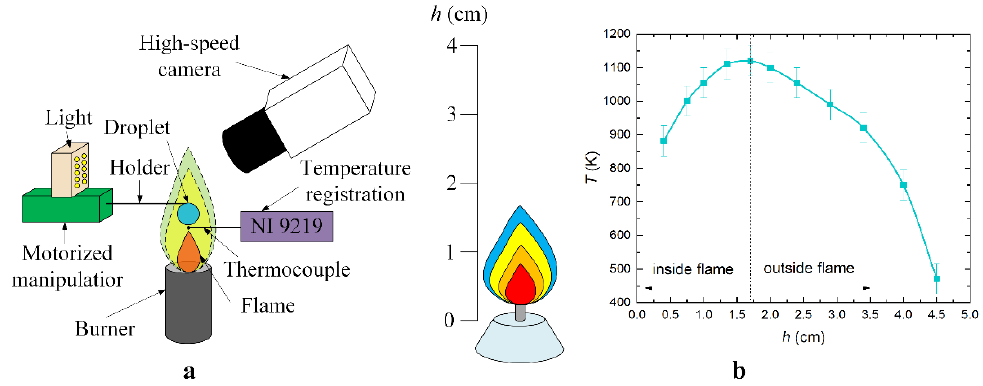
Figure 1. Experimental scheme with an alcohol burner ( a ); temperature measurement scheme in the recording area ( b ). The total errors in temperature (time) measurements were estimated as ± 45 K ( ± 0.1 s).